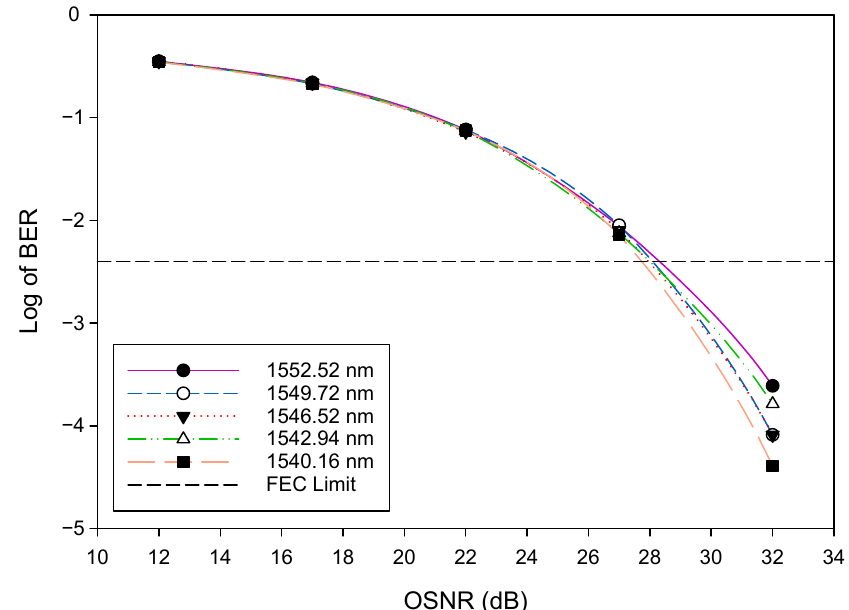
Figure 6. BER versus OSNR plots for downlink.